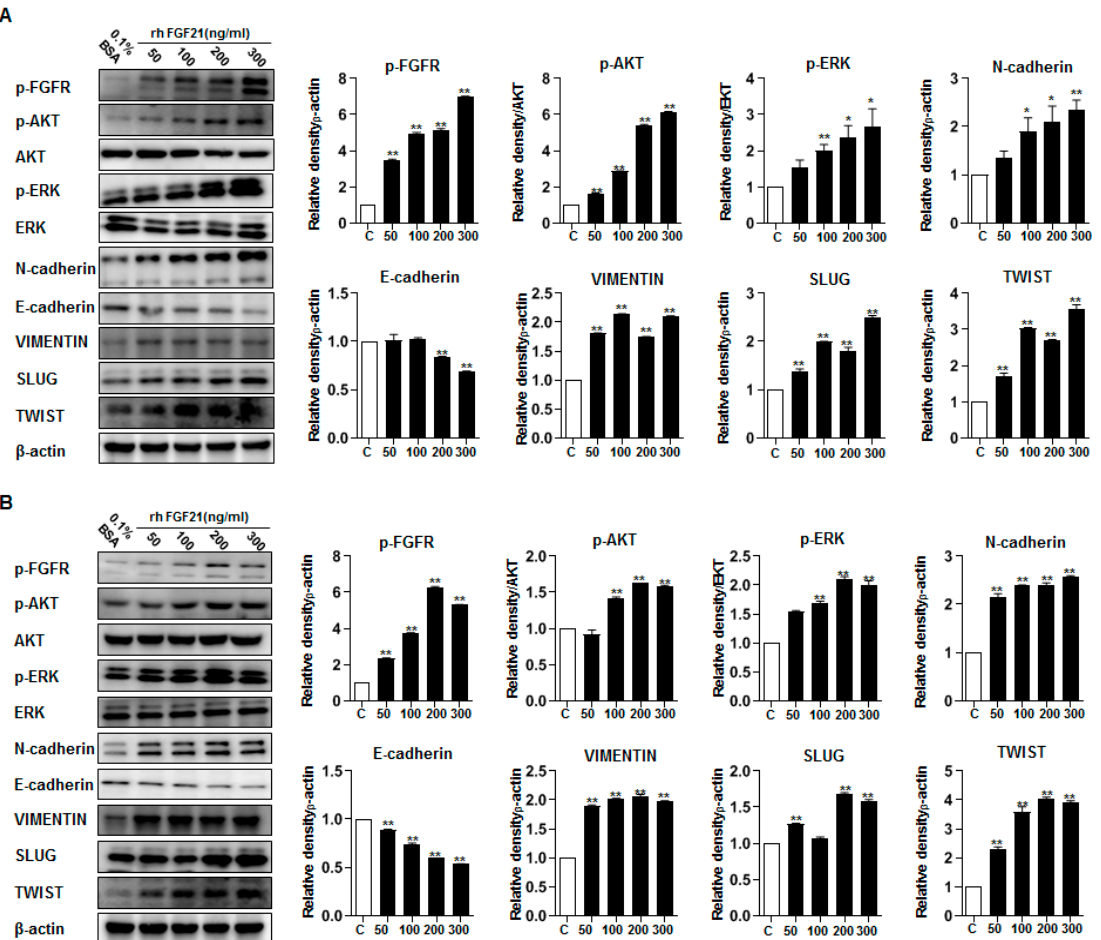
Figure 4. Effects of FGF21 in the FGFR signaling axis, including epithelial–mesenchymal transition (EMT)-associated proteins in thyroid cancer cell lines. ( A ) Representative images of Western blot analyses for the detection of p-FGFR, p-AKT, AKT, p-ERK, ERK, N-cadherin, E-cadherin, vimentin, SLUG, TWIST, and beta-actin in BCPAP cells treated with rFGF21 or 0.1% BSA. ( B ) Representative images of Western blot analyses for the detection of p-FGFR, p-AKT, AKT, p-ERK, ERK, N-cadherin, E-cadherin, vimentin, SLUG, TWIST, and beta-actin in TPC-1 cells treated with rFGF21 or 0.1% BSA. Experiments were performed in duplicate, and all experiments were performed at least three times. ** p < 0.01, * p < 0.05 compared to the 0.1% BSA control.